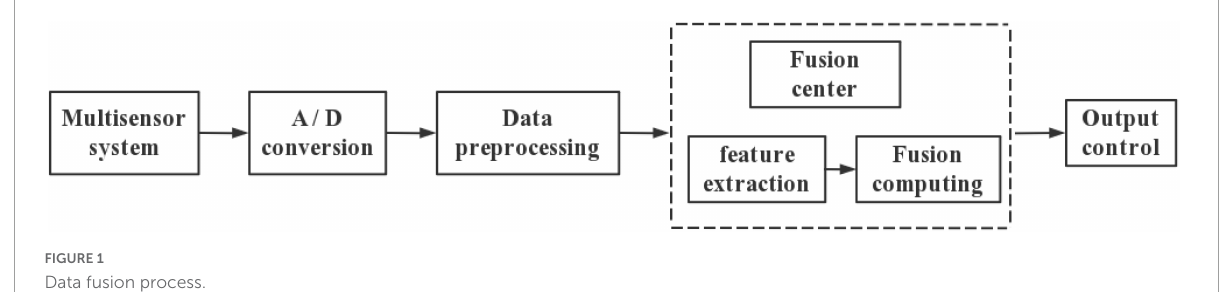
FIGURE1 Data fusion process.